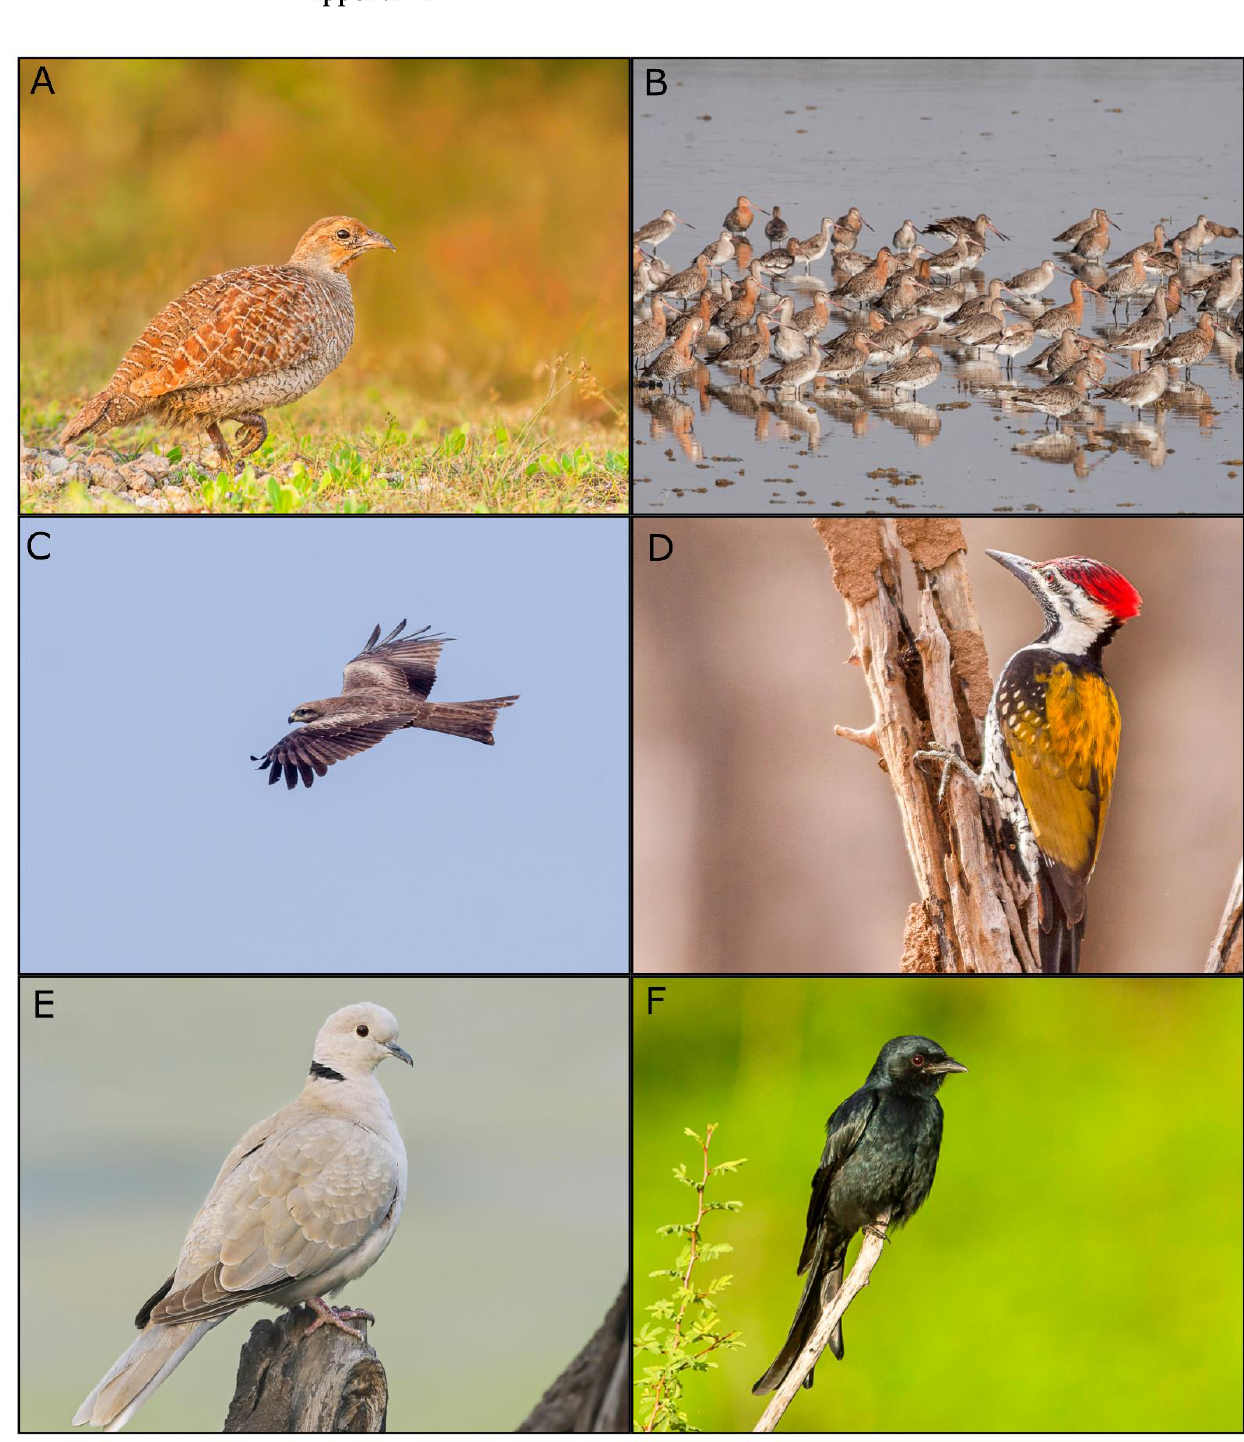
Figure A1. Some northern restricted bird species recorded in the Sarasalai mangrove. ( A ) Gray Francoline, ( B ) a flock of Black-tailed Godwit, ( C ) Black Kite, ( D ) Lesser Golden-backed Woodpecker, ( E ) Eurasian Collared Dover, and ( F ) Black